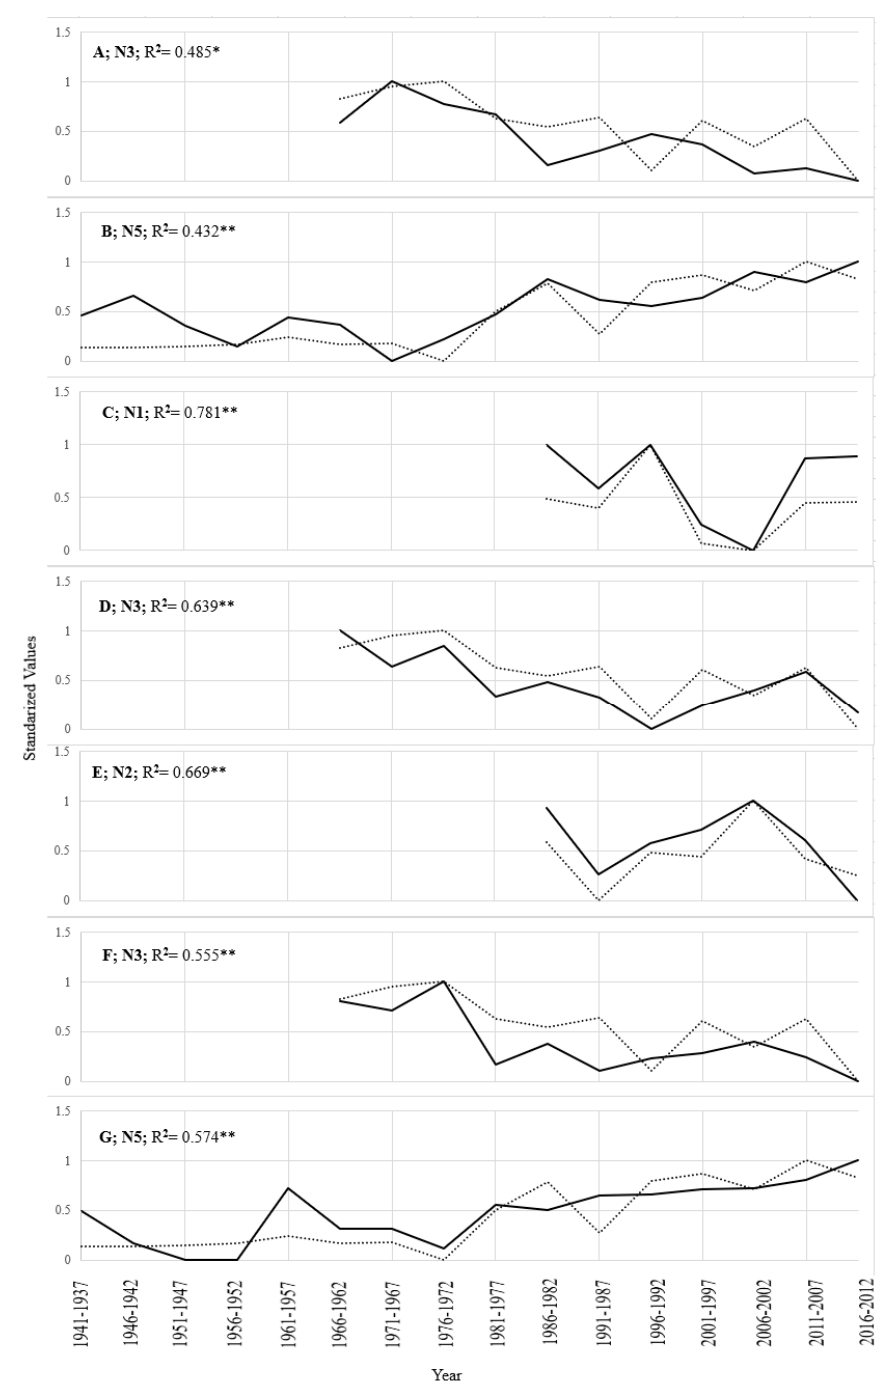
Figure 3. Measured (dotted line) vs. modelled (solid line) normalized percent carbon values from a natural stand of hybrid white spruce within the John Prince Research Forest (N1–N3) and near PG (N5). Data modelled from current year January temperature ( A , B ), current year March precipitation ( C ), average spring temperature ( D ), and current July temperature ( E – G ) from Fort St. James and Prince George climate stations. R 2 values are presented with ** p = 0.01 and * p = 0.05. Note that not all axes are at the same scale .